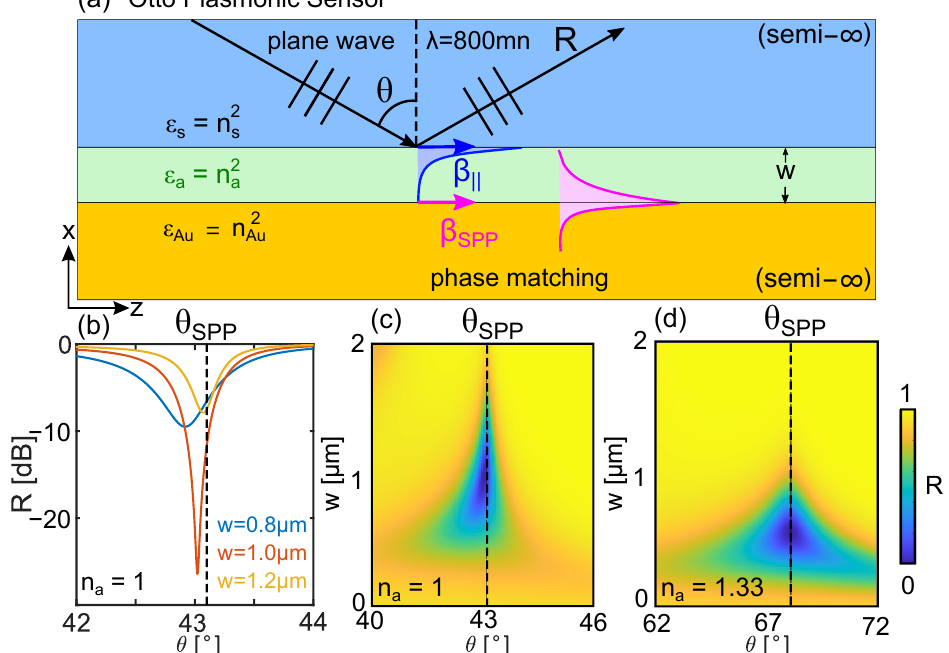
Figure 1. Concept schematic of the challenge of calculating resonances in plasmonic sensors. ( a ) The simple Otto configuration relies on monitoring the reflectivity R of plane waves propagating in semi-infinite media as a function of angle θ . At the angle θ SPP a SPP is excited. ( b ) θ -dependent reflectance spectrum for n a = 1, λ = 800nm, and w as labelled. Also shown is the full colourmap of the reflectance as a function of θ and w for ( c ) n a = 1 and ( d ) n a = 1.33. Note that the spectral maps are subtly dependent on both n a and w